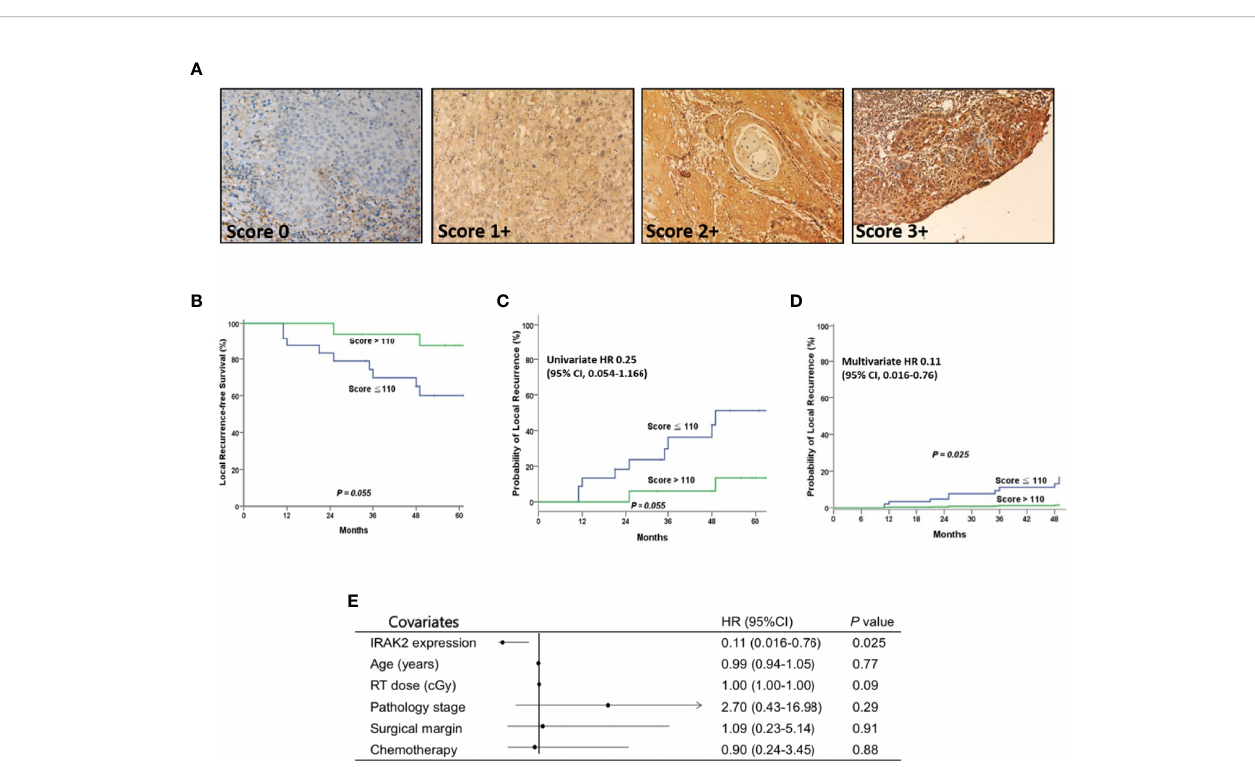
FIGURE 5 | After postoperative radiotherapy, OSCC patients with higher IRAK2 expressions showed better local recurrence-free survival (LRFS) than those with lower IRAK2 expressions. (A) Representative micrographs demonstrated the immunohistochemical (IHC) scores of IRAK2 expression in oral squamous cell carcinoma. (magni fi cation, x200). (B) Kaplan-Meier survival curves represented that patients with higher IRAK2 expressions (i.e., >110) seemly demonstrated better 5-year LRFS than that of patients with lower expressions (i.e., 87.4% vs. 60.0%; P = 0.055, a statistical trend). (C) Cox proportional hazard regression con fi rmed this observation (univariate HR 0.25; 95% CI, 0.054 - 1.166; P = 0.055, a statistical trend). (D) Remarkably, after multivariable analysis, the two groups showed a statistically signi fi cant difference in terms of post-irradiation LRFS (multivariate HR 0.11; 95% CI, 0.016 - 0.760; P = 0.025). (E) Forest plot of multivariate analysis, depending on the Panel (D) Note that seven factors were used for multivariate analysis of LRFS (Panel C): age, gender, pathological stage, RT dose, chemotherapy, the status of surgical margin, and the expression level of IRAK2.